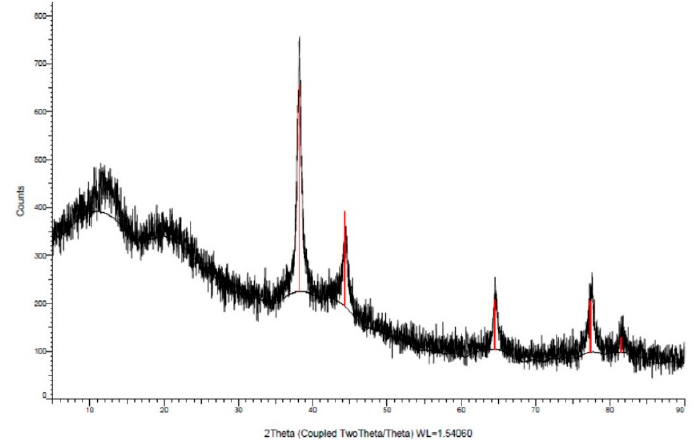
Figure 2. Image of scanning electron microscope (SEM) for the biosynthesized nanoparticles.